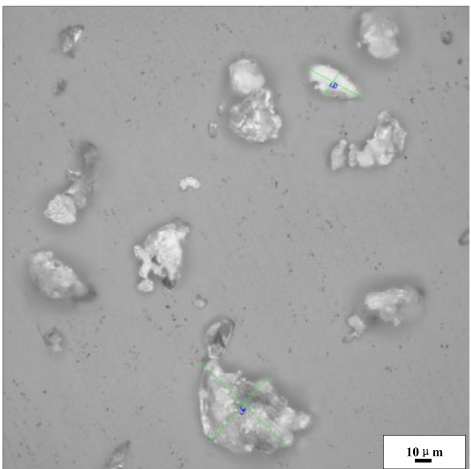
Figure 1. The microgram of PEKK powers.